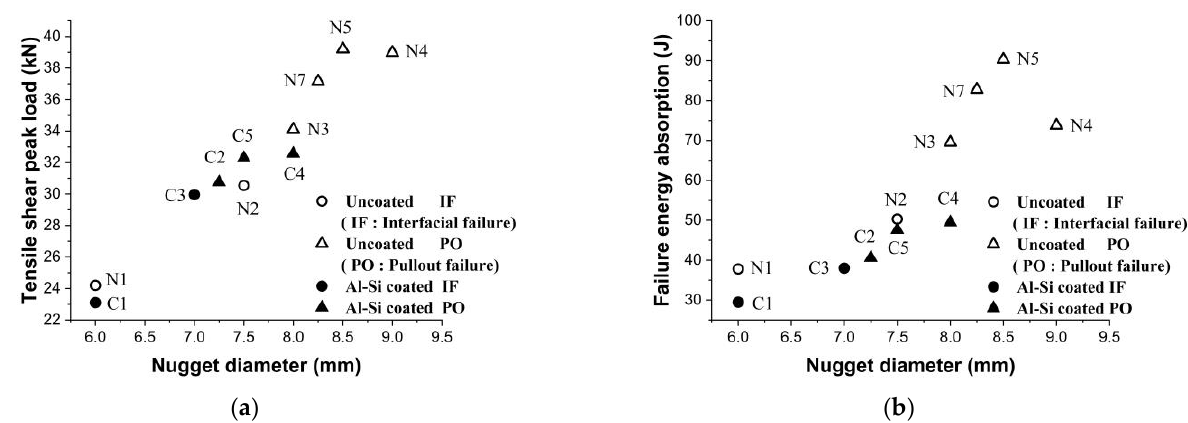
Figure 10. ( a ) Tensile shear failure load with nugget diameter for both types of material and ( b ) Failure energy absorption with nugget diameter for both types of material.